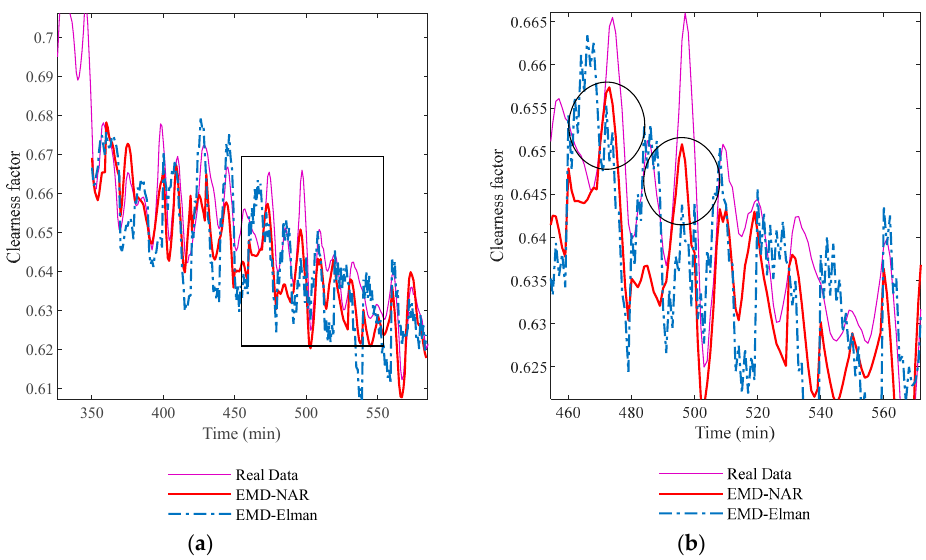
Figure 12. Using EMD to predict at different starting points. 350 min, ( a ) and partial enlarged figure ( b ).